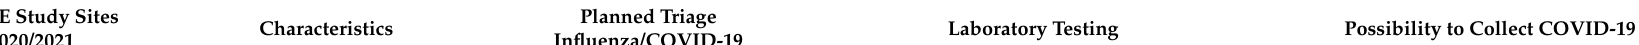
Table 3. DRIVE study sites: triage and testing strategies as well as ability to collect information on COVID-19 variables for the 2020/21